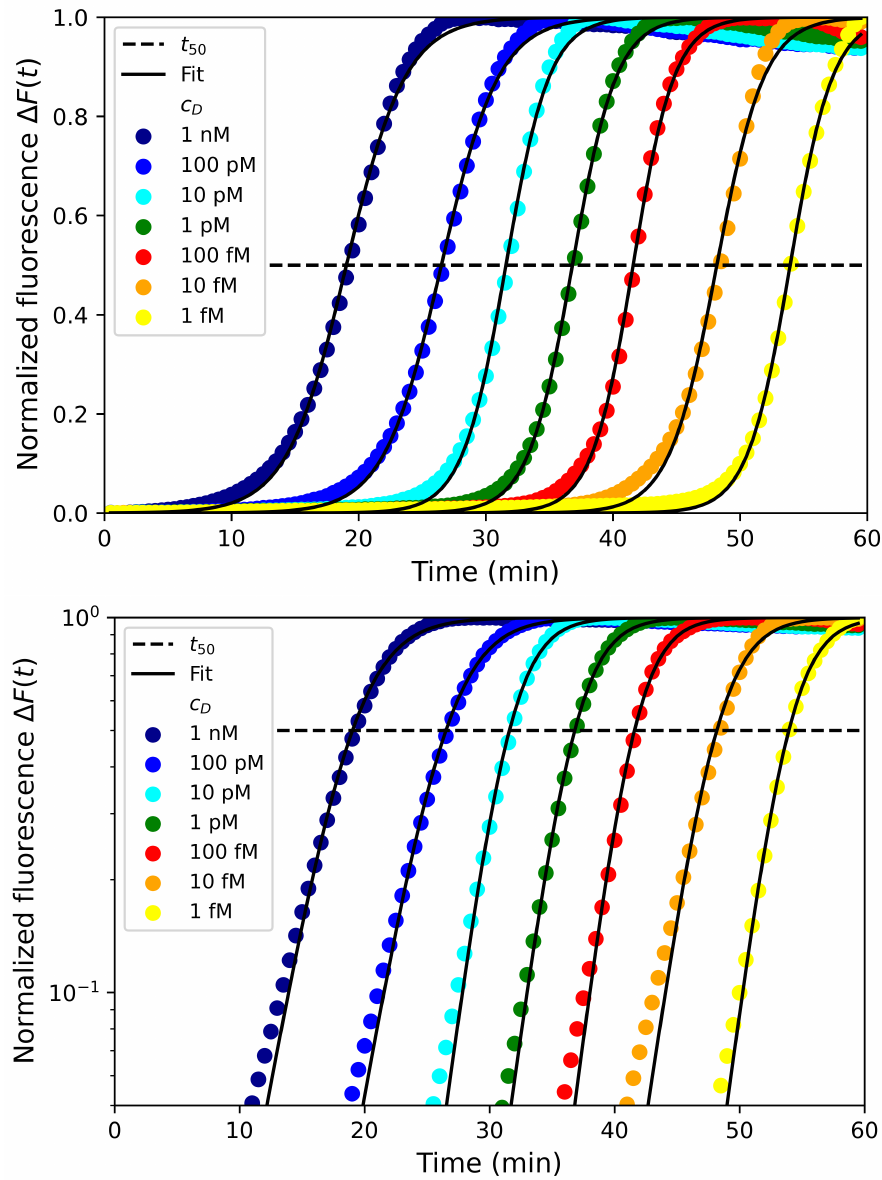
Figure 4. Normalized fluorescence ∆ F in linear ( above ) and logarithmic ( below ) scales as function of time for various concentrations of the dumbbell MD from 1 nM to 1 fM. The black dashed line is the half-saturation threshold for the determination of t 50 . The dark lines are the logistic fit of the experimental